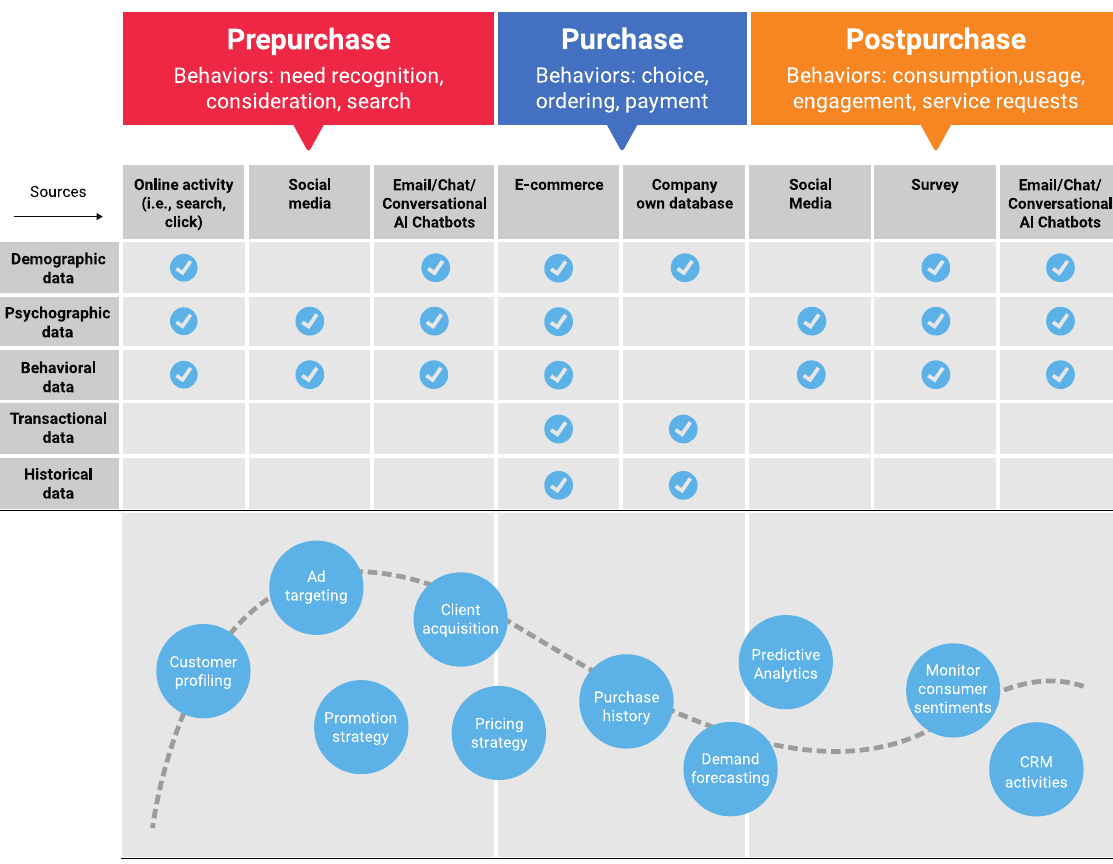
Figure 4. Big Data and AI framework for the customer journey